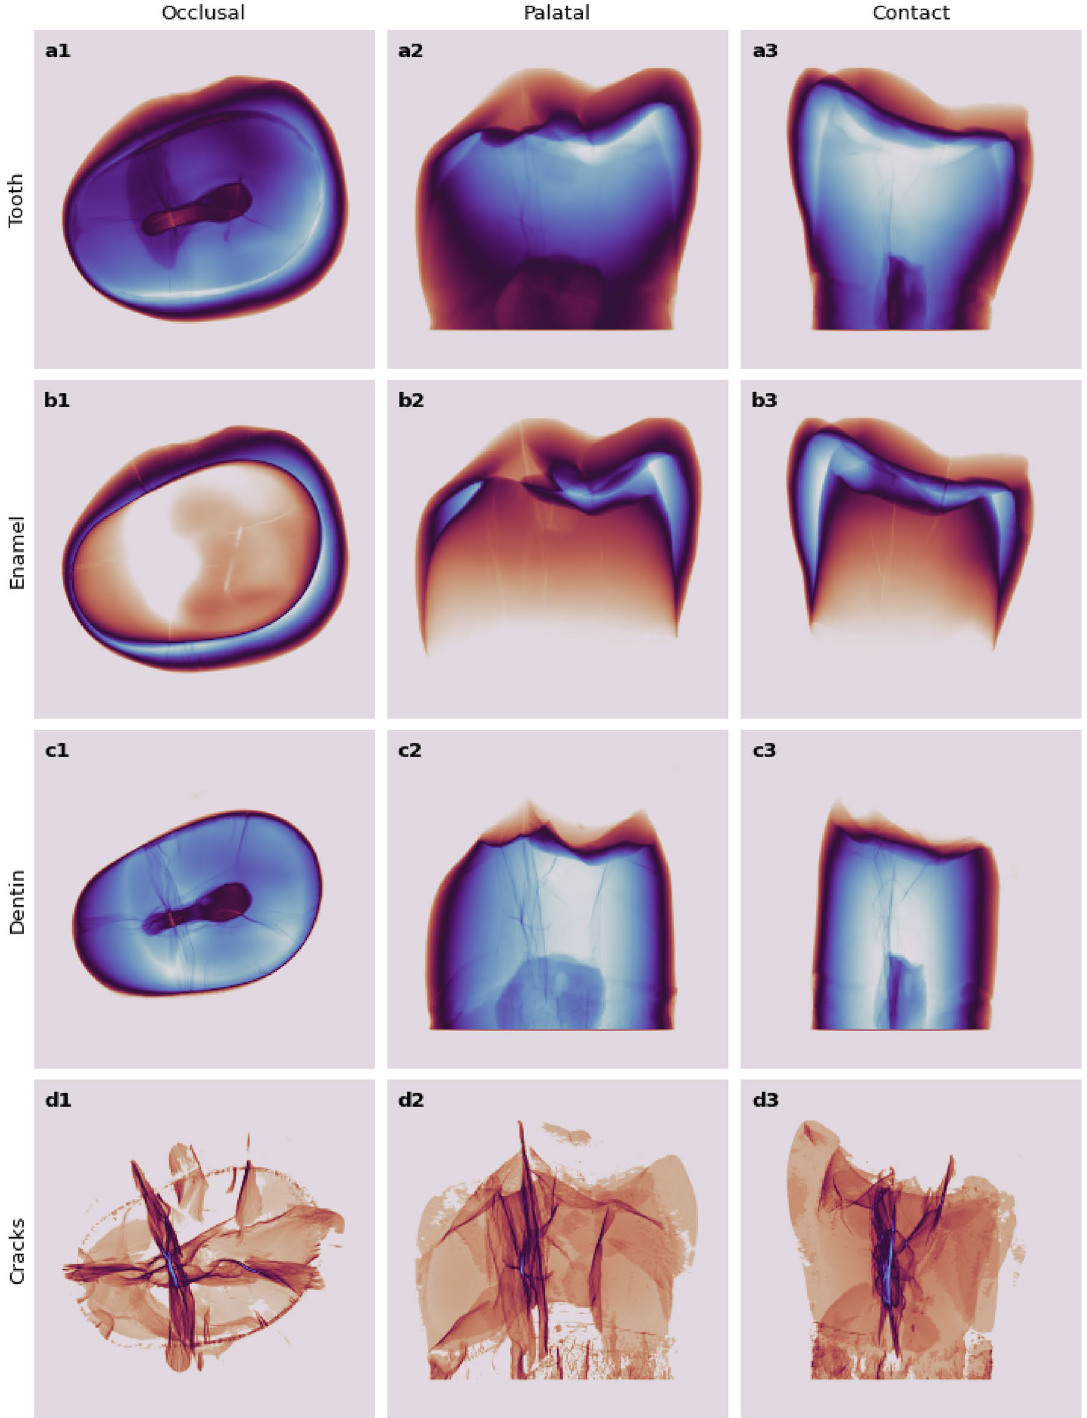
Figure 5. X-ray µ CT data-cube projected density maps (bluish higher / brownish lower) along three major axes indicate convolutional neural network segmented voxels belonging to: ( a1 – a3 ) the tooth, ( b1 – b3 ) enamel, ( c1 – c3 ) dentin, and ( d1 – d3 ) cracks (color intensity scaled as square root for